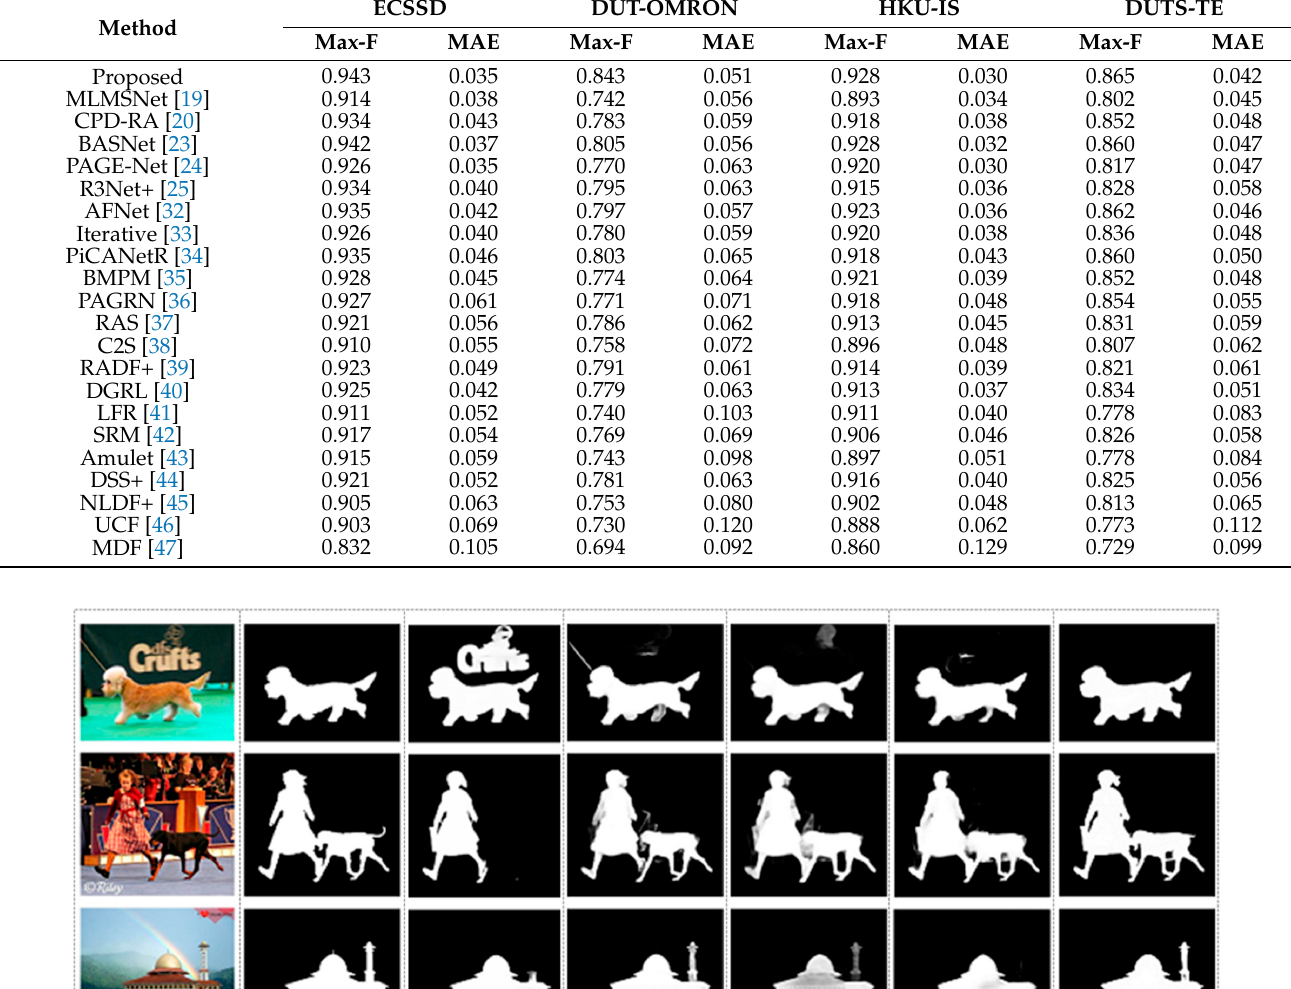
Table 2. Comparison with former schemes. The records highlighted in green, blue and red colors indicate first, second and third best.